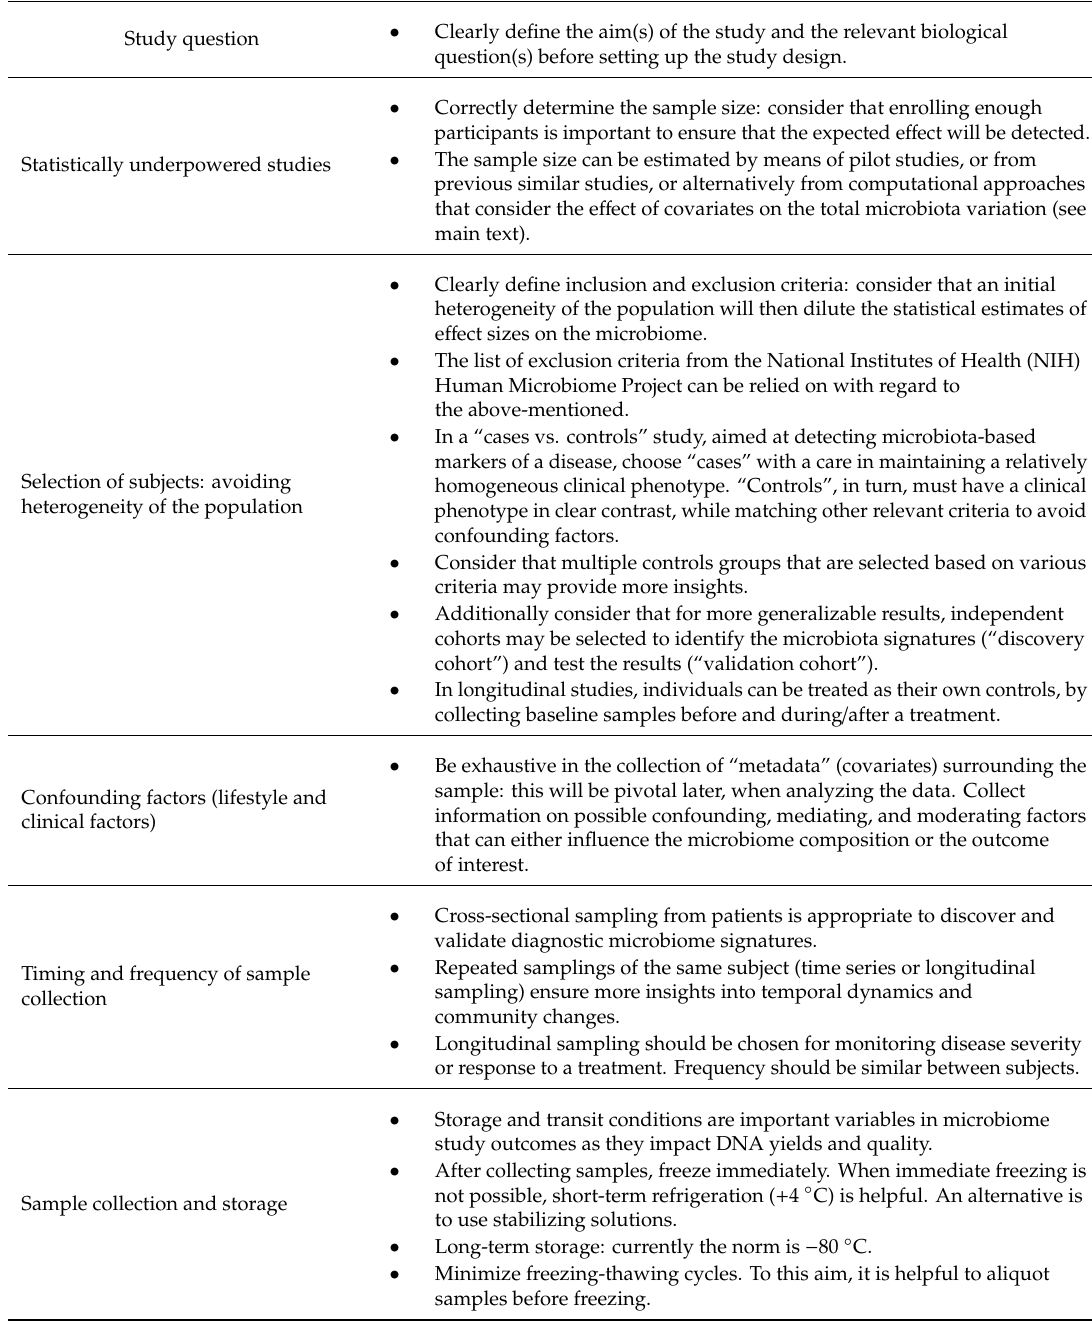
Table 1. Practical aspects to follow when drawing and studying a